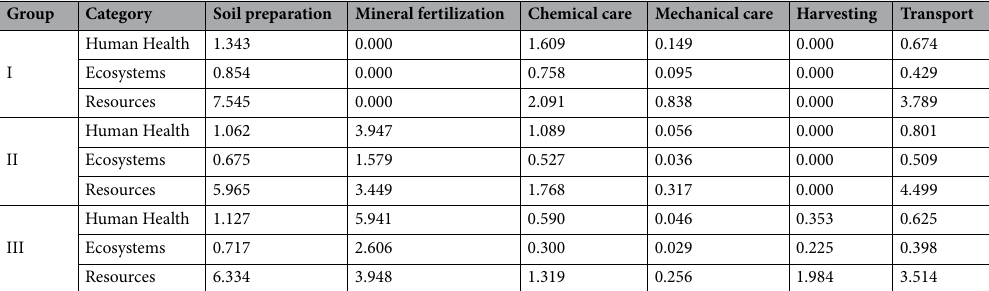
Table 10. The environmental impact of the consumption of production material, as per plantation area (Pt·ha −1 ).